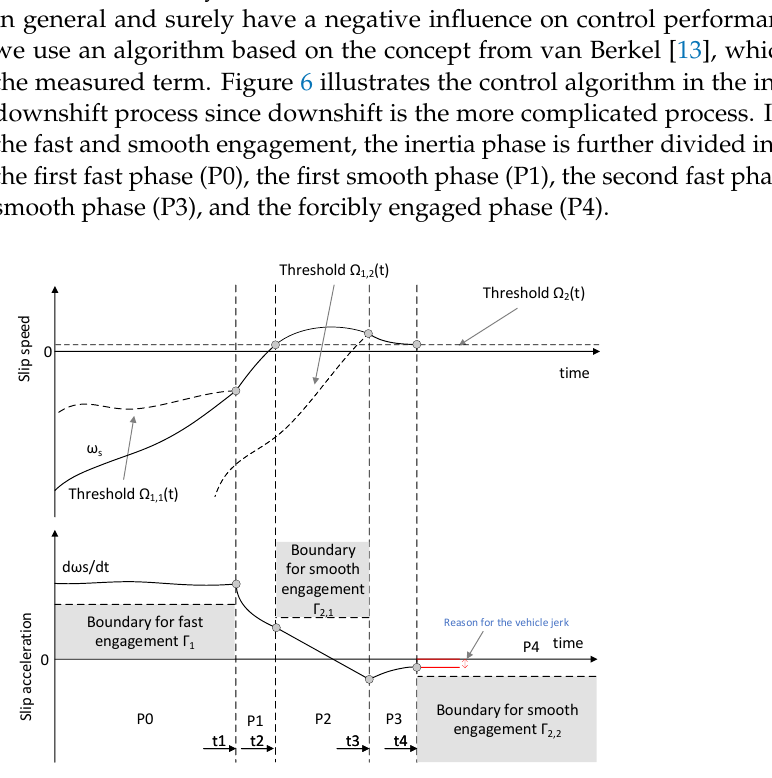
Figure 6. Algorithm explanation during the downshifting inertia phase: Ω 1,1 ( t ) and Ω 1,2 ( t ) are the triggers for the first and second smooth phase